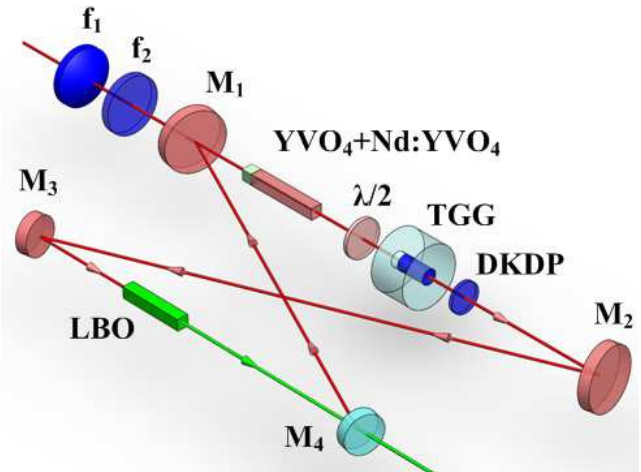
Figure 11. Experimental setup of active compensation for the thermal lens effect of the TGG crys- tal [27]. Reprinted with permission from [27] c (cid:13) The Optical Society.